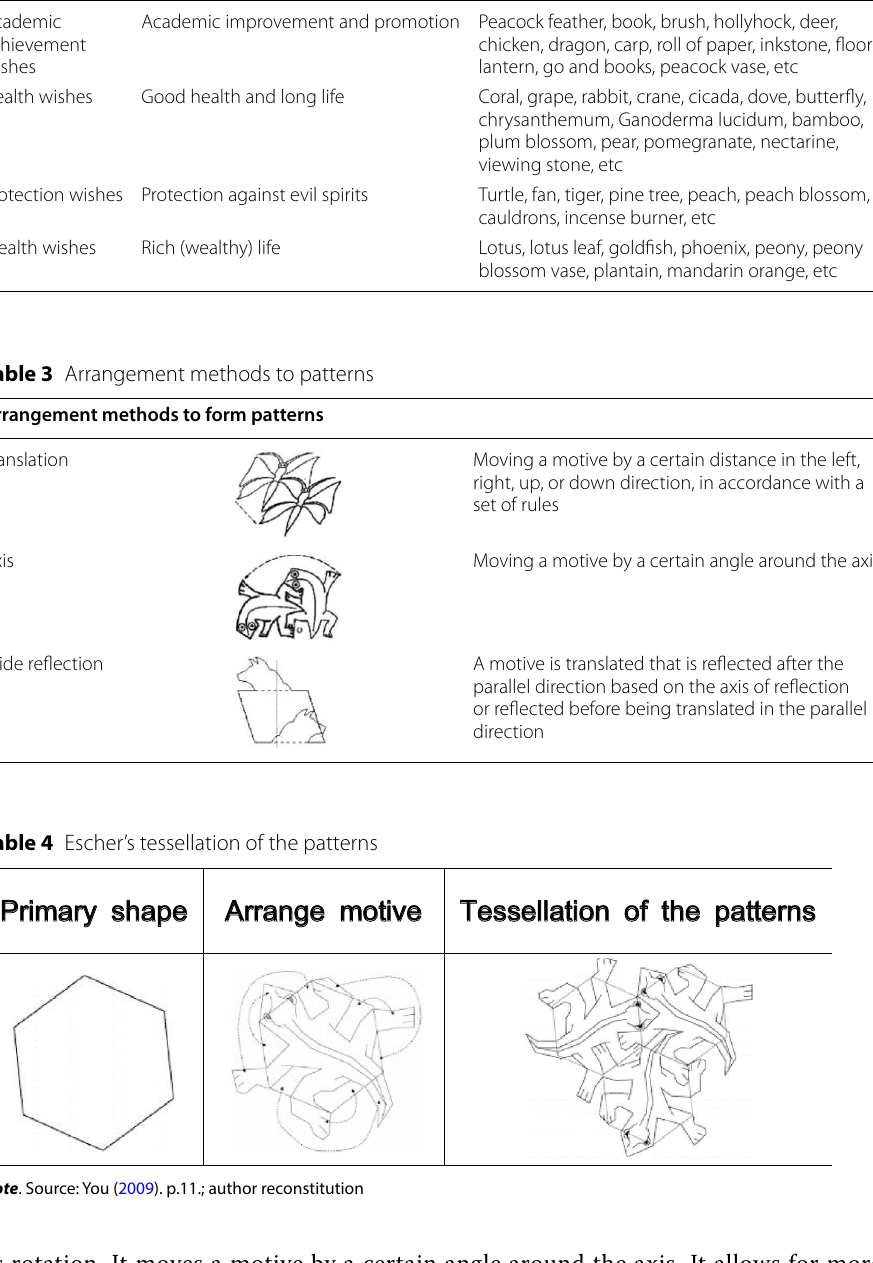
Table 2 Classification of the themes according to symbolic meaning of Chaekgeori icons Theme